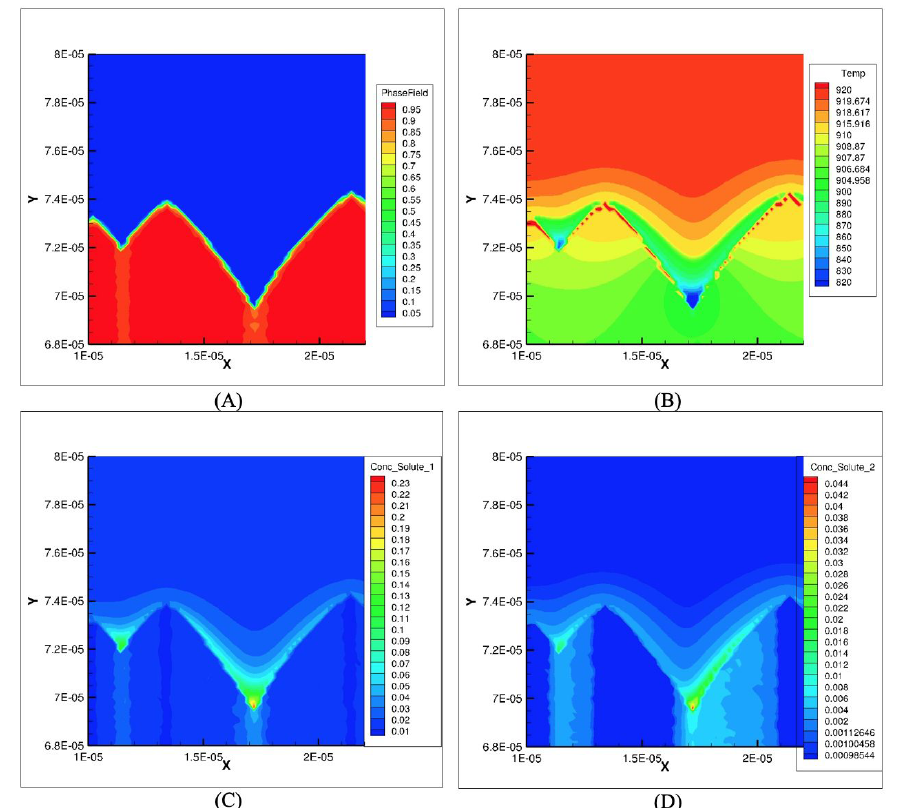
Figure 1. Phase-field simulation for a ternary Al-4wt%Cu-0.1wt%Si alloy for t = 0.008506816s at liquidus temperature (A) magnification of phase field variable of a cellular microstructure, (B) temperature distribution, (C) copper concentration and (D) silicon